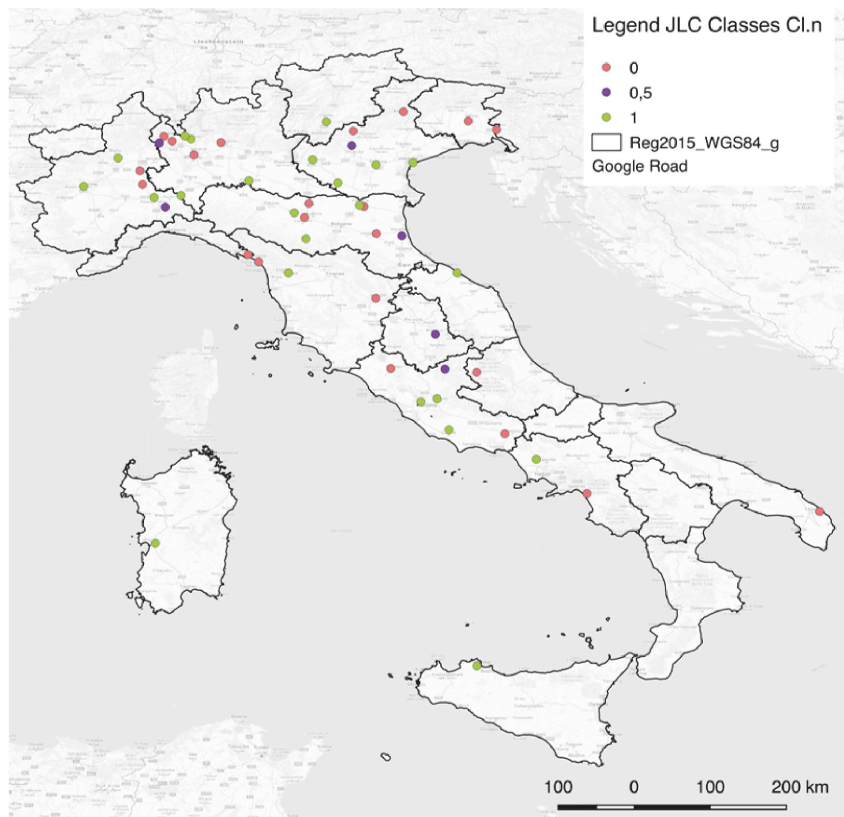
Figure 8: MCSDA implementation for JLC: assigning of Classes Cl.n(A.n), spatial